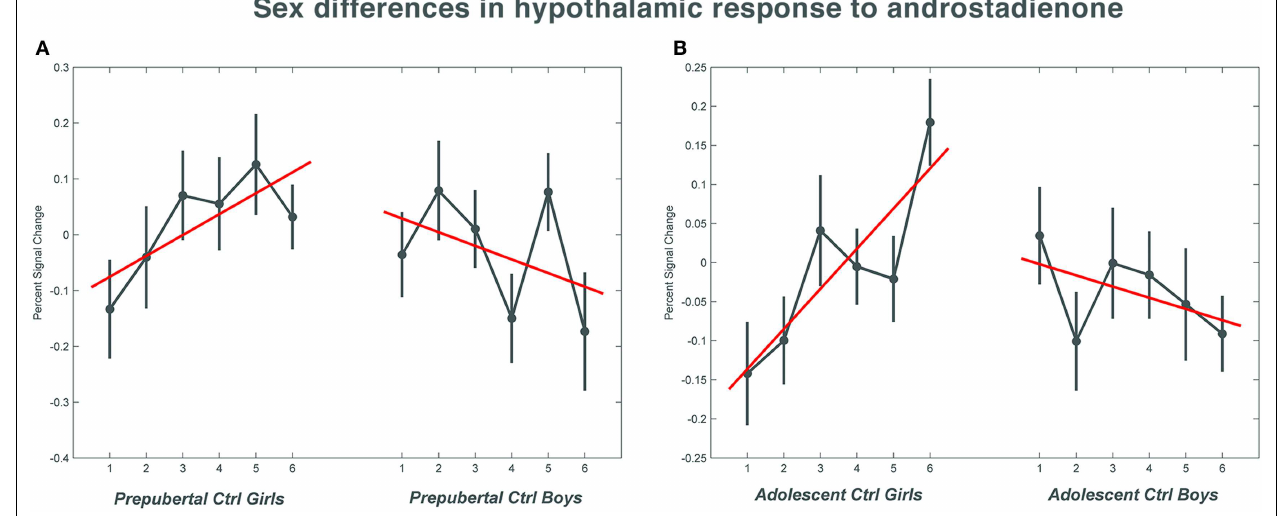
of pubertal status, both female age groups showed a significant increase ( p = 0.033 in the pre-pubertal girls; p = 0.019 in the adolescent girls) in activation with repeated exposure to androstadienone, whereas hypothalamic activations tended to decrease in boys toward the end of the odor stimulation. The data for this figure was visualized using the toolbox rfxplot by Gläscher (55).